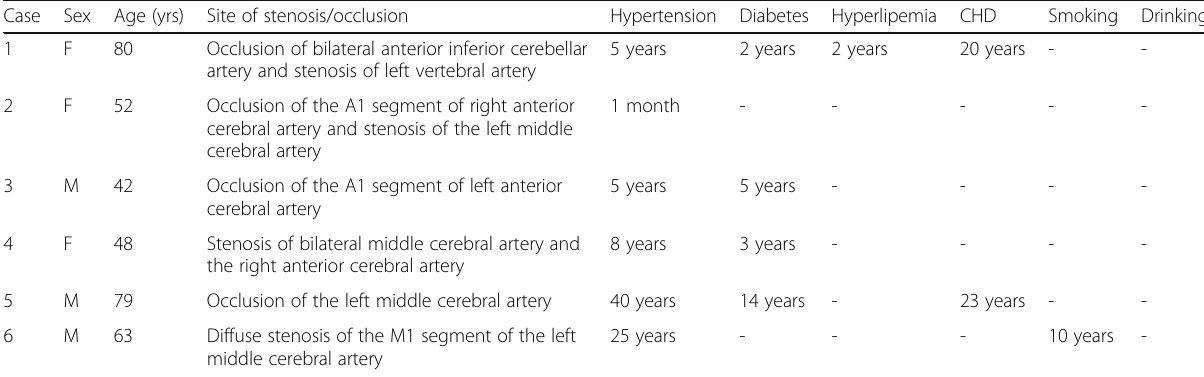
Table 2 Clinical characteristics of 6 non-MMD ICASO patients with the RNF213 p.R4810K